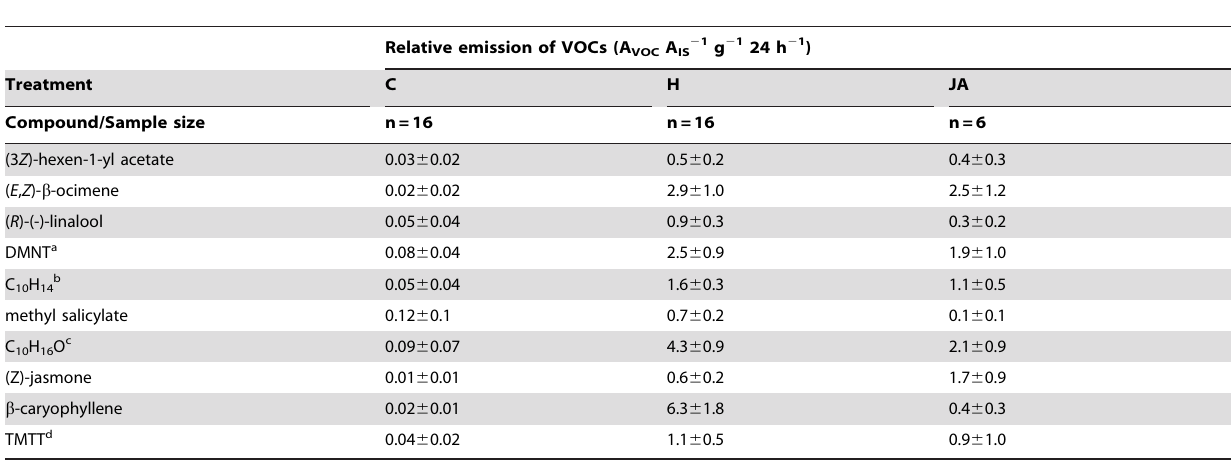
Table 2. Qualitative and quantitative comparison of the VOC profiles emitted from lima bean plants after different treatments.